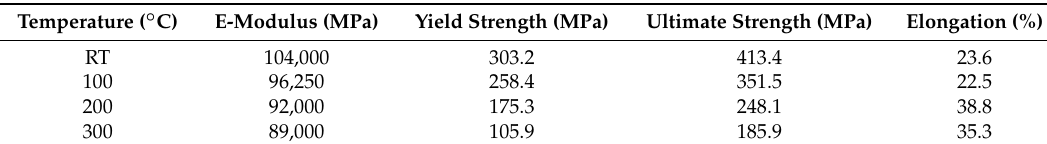
Figure 1. Schematic drawing of the tensile specimen.